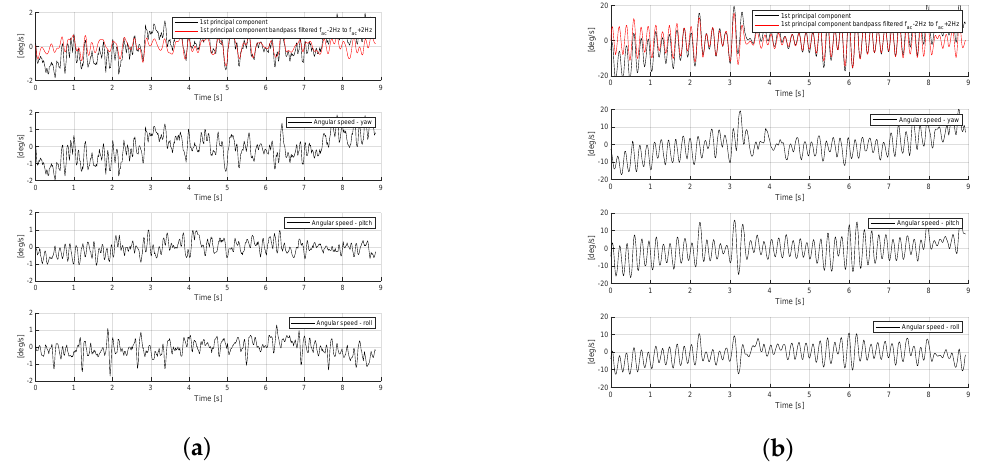
Figure 8. Gyroscope signal measured at the head of a patient with cervical dystonia. ( a ) Patient-1, without head tremor (from A1 group); ( b ) Patient-28, with head tremor (from B1 group).